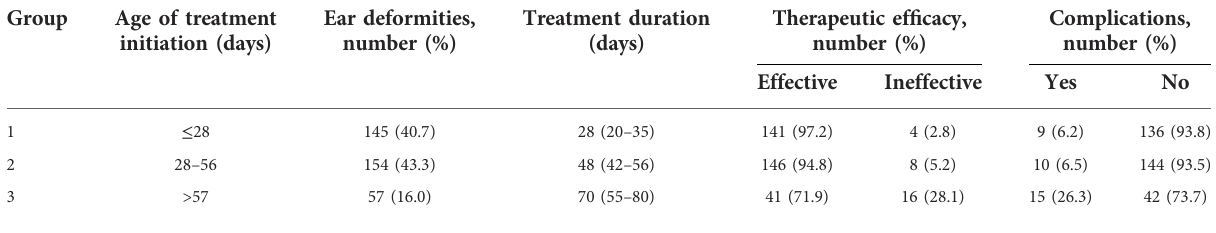
TABLE 4 Comparison of treatment outcomes among different subgroups of infants.